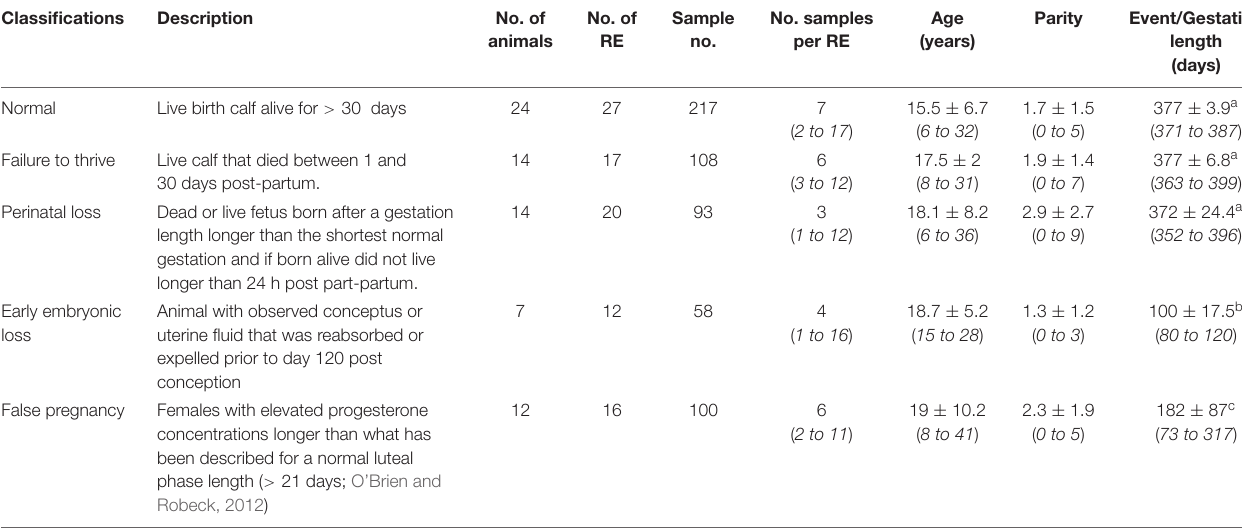
TABLE 1 | Classification of and sample collection characteristics, number of females within each group, mean ± sd ( range ) age at conception of animals within each group and number of previous calves prior to conception (parity). Classifications Description No. of